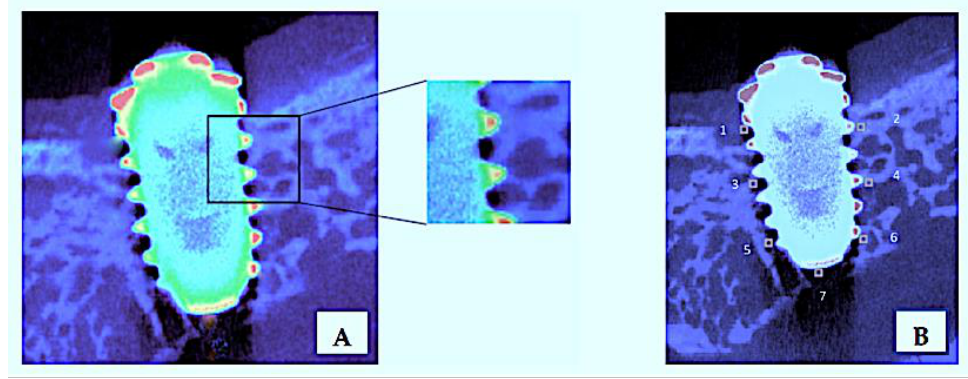
Figure 2. Bone implant contact area ( A ) and regions of interest (ROIs, 1–7) ( B ).